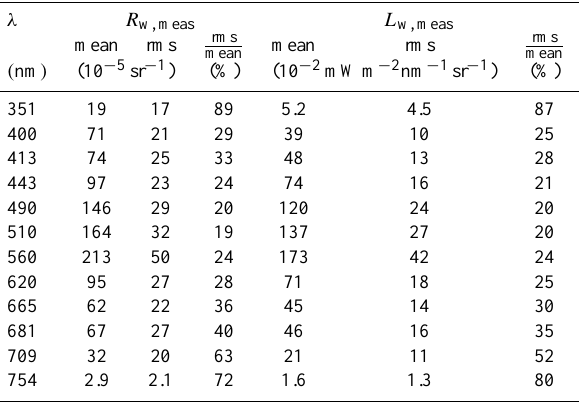
Figure 6. Estimated vs. measured values of the remote sensing re- flectance R w for all data sets and wavelengths. Table 5. Mean values of measured remote sensing reflectance R w, meas and water-leaving radiance L w, meas , and the rms devia- tions between these quantities and the corresponding estimated val- ues.